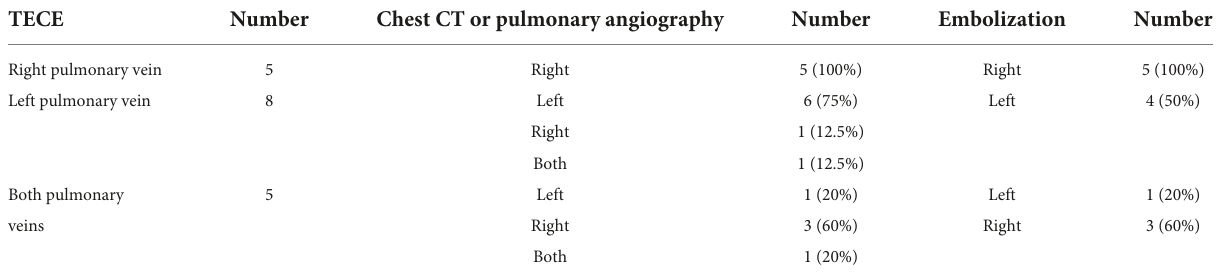
TABLE 5 Comparison of PAVM locations assessed by TECE, a radiologic imaging study (chest CT or pulmonary angiography), and embolization. TECE Number Chest CT or pulmonary angiography Number Embolization